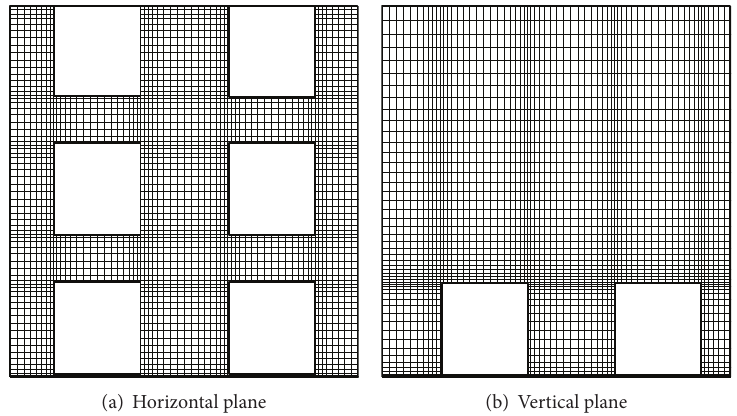
Figure 2: Grid distribution in horizontal and vertical